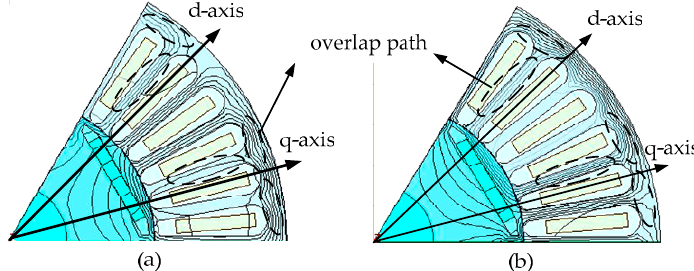
Figure 1. Magnet flux circuit under different current excitation meanwhile set as Ψ f = 0. ( a ) d -axis magnet flux circuit with i q = 0; ( b ) q -axis magnet flux circuit with i d = 0.